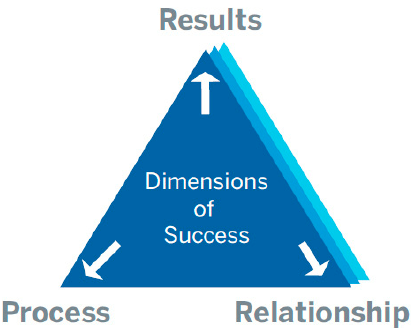
Figure 2. Facilitation Framework for Collaborative Learning.